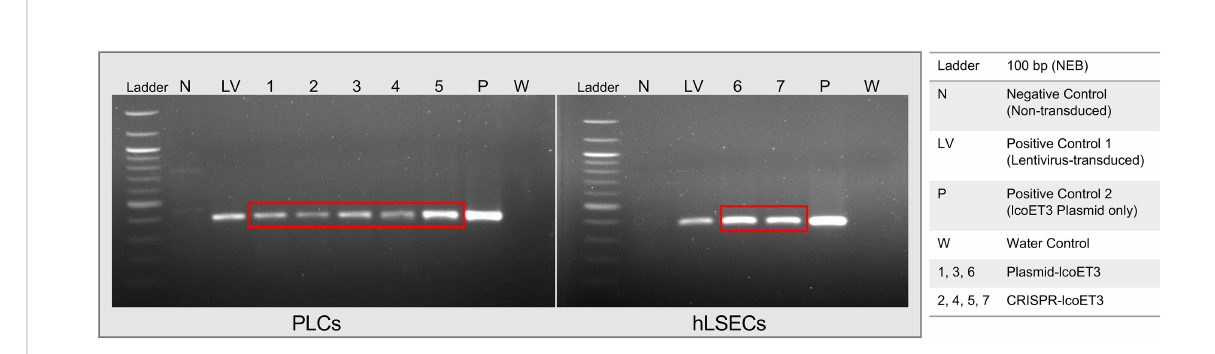
FIGURE 2 Veri fi cation of lcoET3 transgene DNA in gene-modi fi ed PLCs and hLSECs using PCR. DNA was extracted from control and gene-modi fi ed cells (3 passages after transduction/transfection) and subjected to PCR with primers designed to amplify a 395-bp region within the lcoET3 sequence. Agarose gel electrophoresis was then performed to visualize the size of the PCR products. Unmodi fi ed control cells and a reaction containing all constituents of the PCR except for template DNA (water/no-template) were used as negative controls while LV-lcoET3 cells and pure lcoET3 plasmid were used as positive